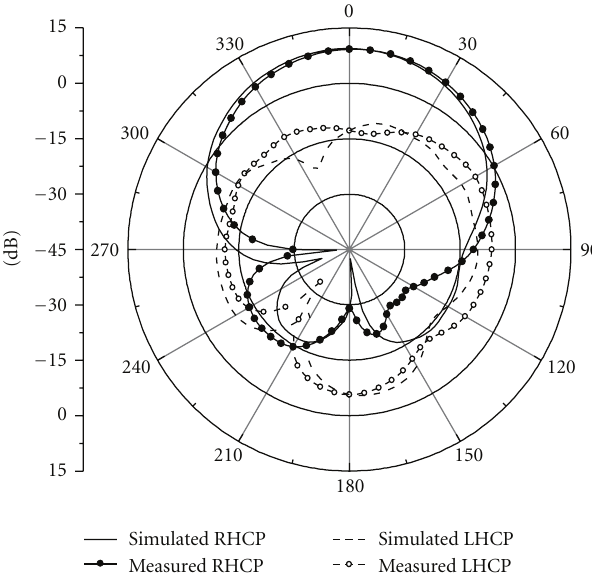
Figure 7: Simulated and measured radiation pattern at the center frequency 1.593